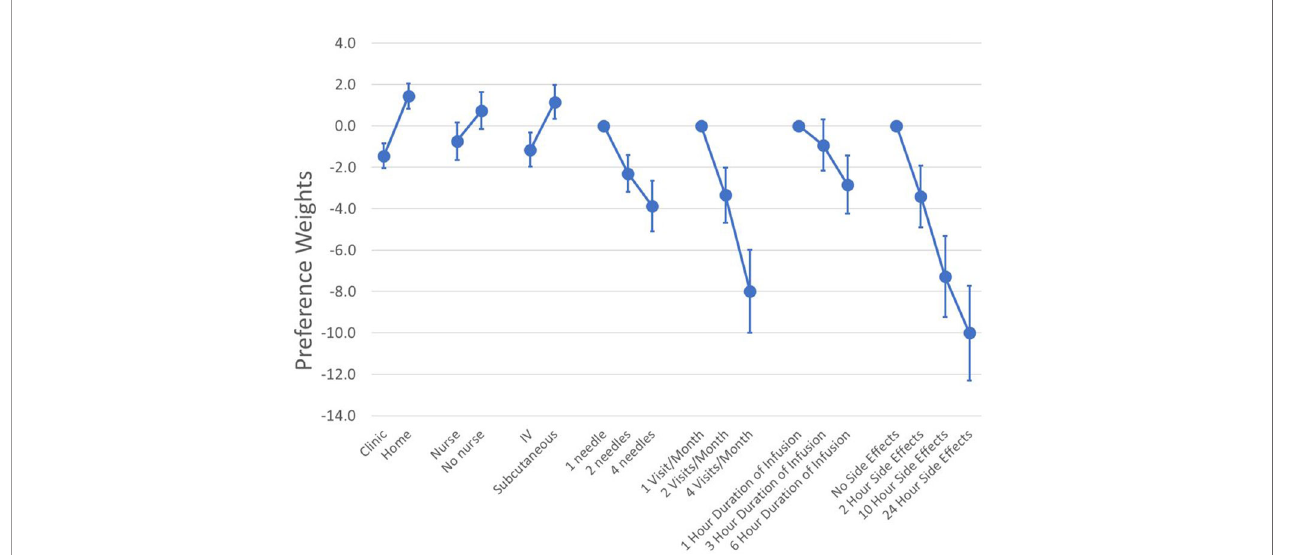
FIGURE 2 | Mean preference weights (N = 119). Log-odds preference weights for all respondents. The absolute value of the weights has no direct meaning. What matters is the relative size of the vertical differences between preferences weights. This is because that vertical distance is correlated with changes in the probability of choice given the attribute change. For example, increasing the duration of infusions from 1 hour to 6 hours reduced the preference weights from 0 to -2.8. Similarly, an increase in the time with side effects from no side effects to 10 hours of side effects decreased the preference weights from 0 to -7.3. This means that the 10-hour increase in the duration of side effects was about 2.6 times (2.6 = -7.3/-2.8) as important as 5-hour increase in the administration time.